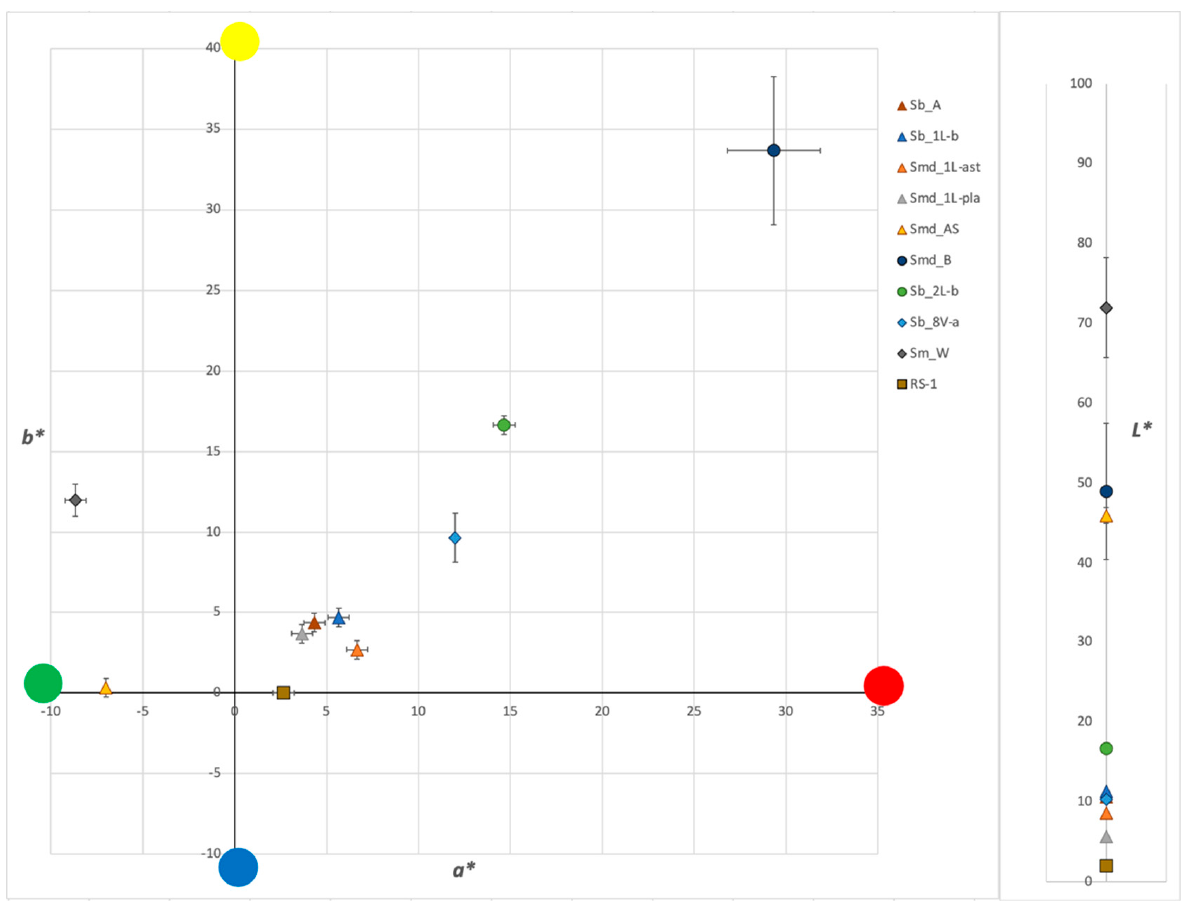
Figure 7. L * a * b * colorimetric coordinates of the varnishes’ fluorescence under UV light (cf. Figure 2). ▲ : bleached dewaxed shellac; ⬤ : orange shellac with or without wax; ◆ : seedlac and shellac wax; ■ : non-varnished references.